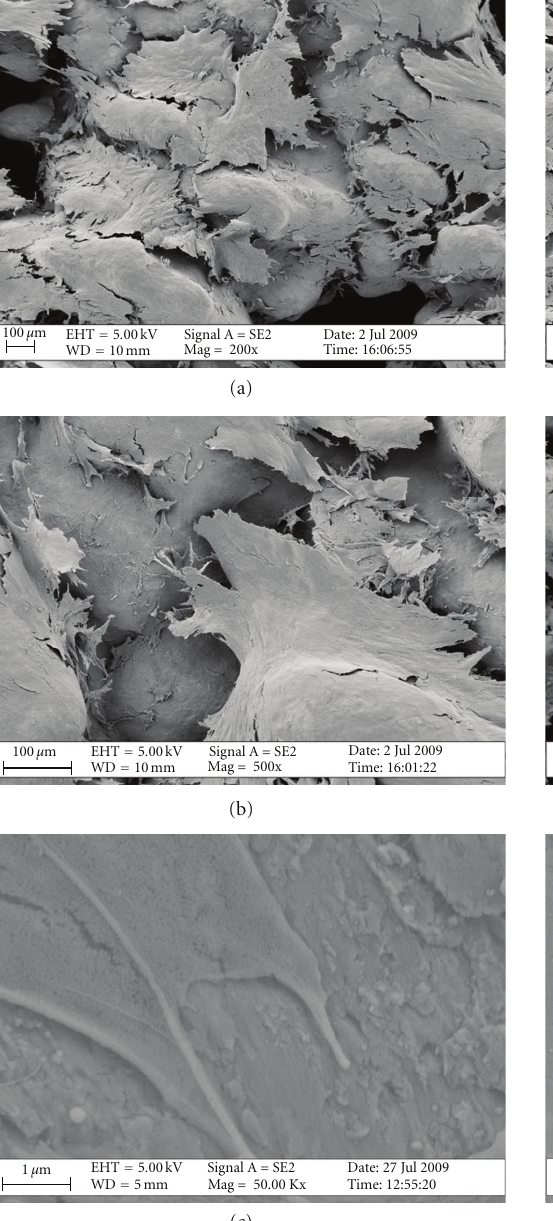
of the sca ff old pores, cells appeared to follow the curvature of the surface and stretch out inside the pore both when seeded on cp-Ti (Figure 3(b)) and Ti6Al4V (Figure